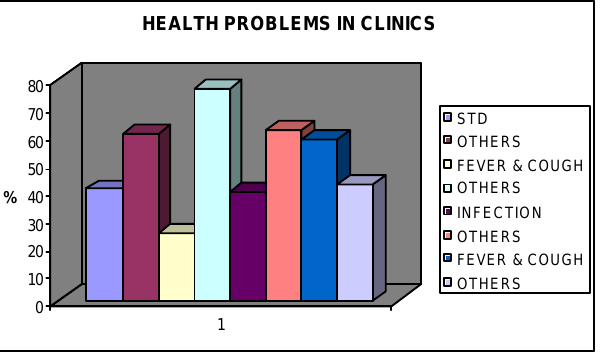
Fig. 2 : Showing maximum health problems in clinics prescription (for checking polypharmacy)